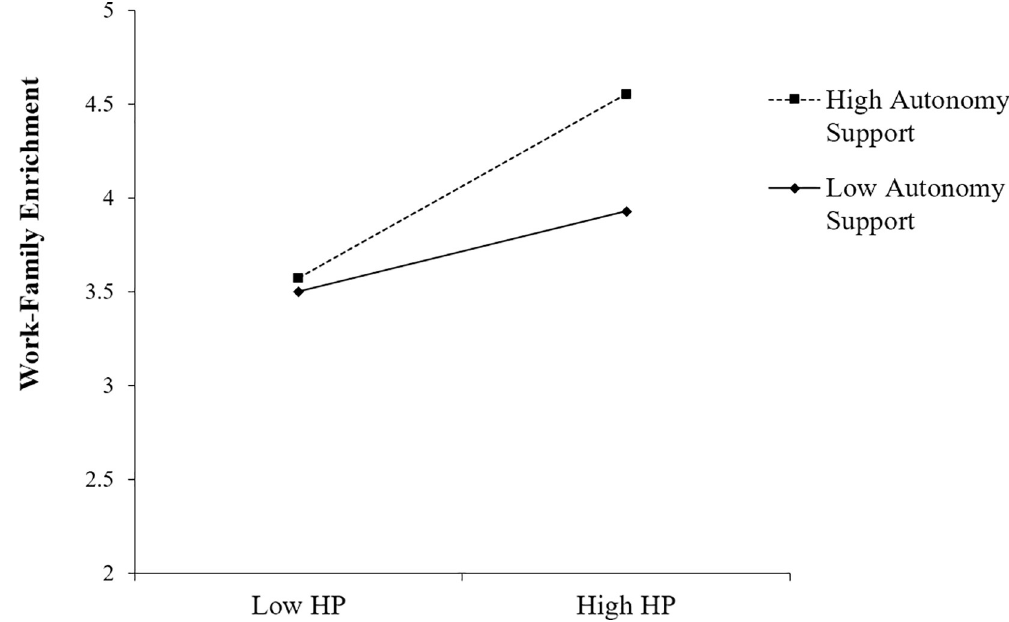
Fig 3. Interaction effect of harmonious work passion and autonomy support on work–family